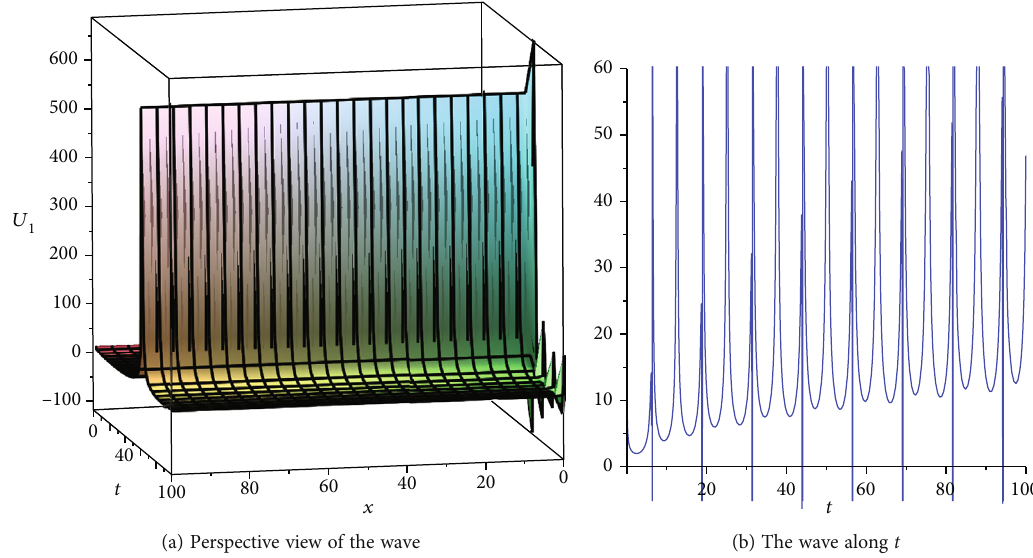
Figure 4: Wave pro fi les of exact solution U